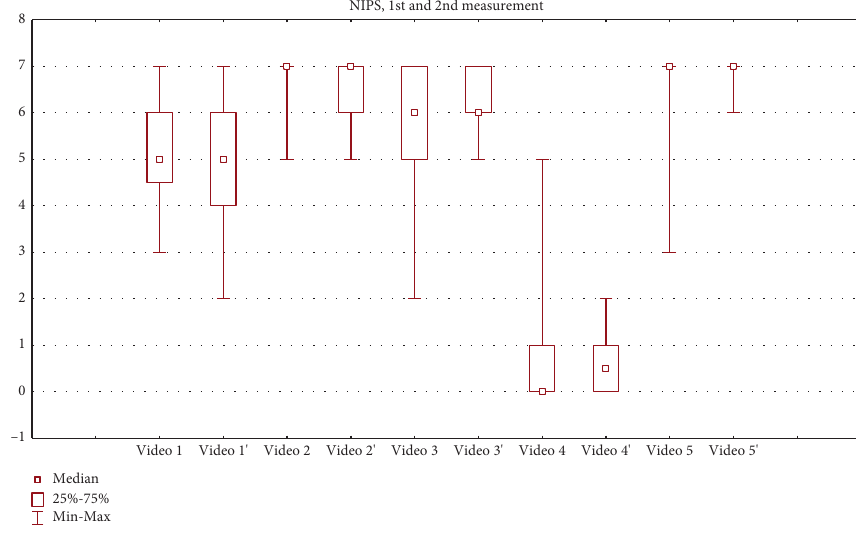
Figure 2: NIPS scores. 2 nd measurements are marked